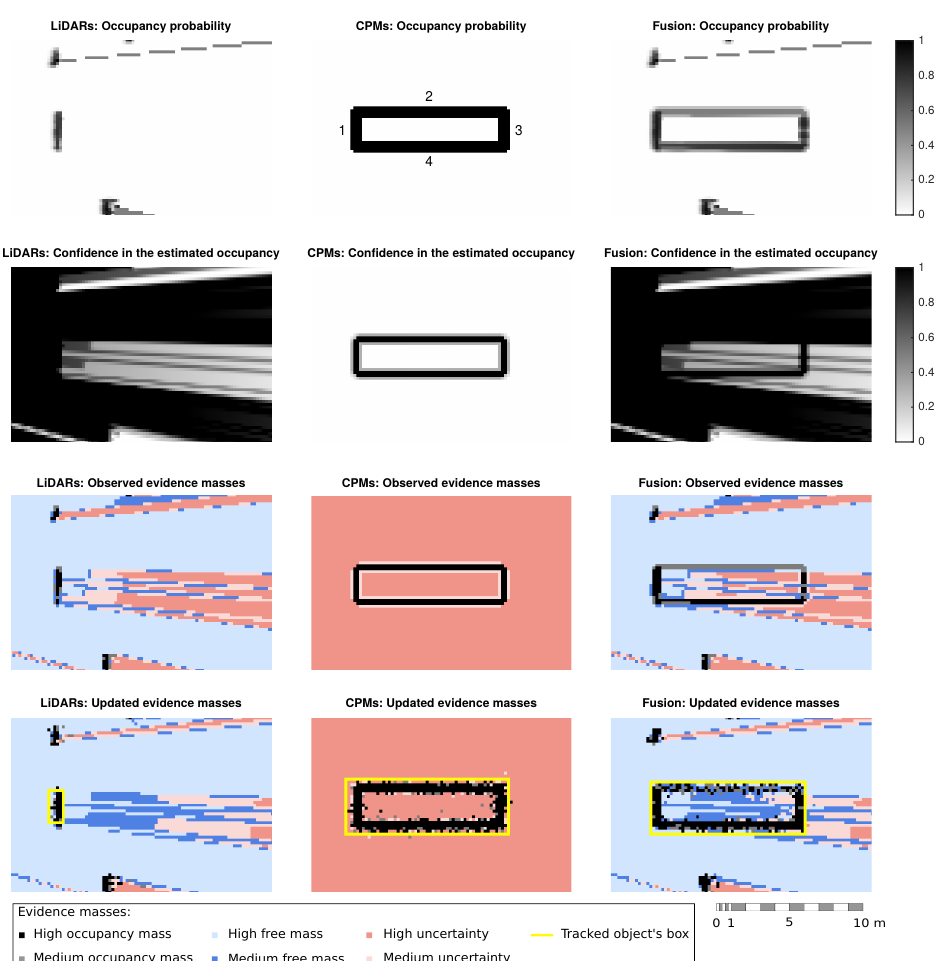
Figure 8. Evolution of the perception algorithm using only LiDAR sensors, only CPM data and the combination of